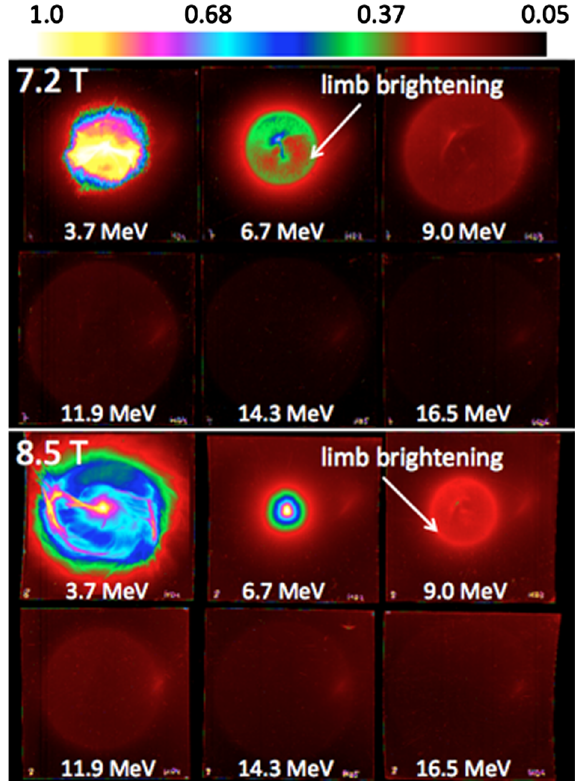
FIG. 6. Radiochromic film images: The films record the trans- verse position of the protons after they have been transported through a 7.2 T (top) and 8.5 T (bottom) solenoidal field. Proton energies corresponding to Bragg peak dose depositions are shown at the bottom of each film, and arrows point to areas of limb